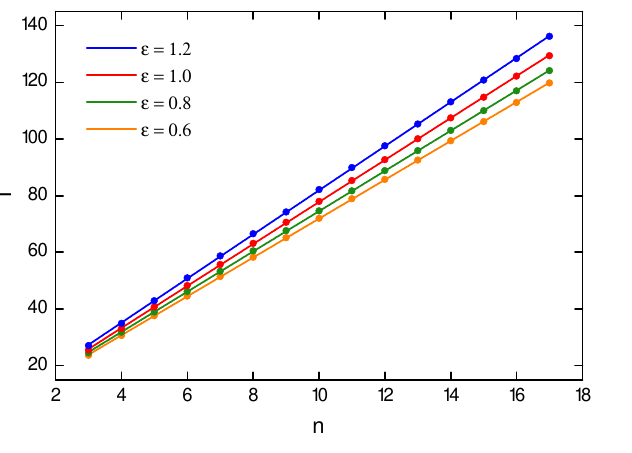
Figure 12 . The time T between the two collisions as a function of the window number n = 3 . . . 17 for two-bounce resonance windows with (cid:15) = 1 . 2 , 1 , 0 . 8 and 0 . 6